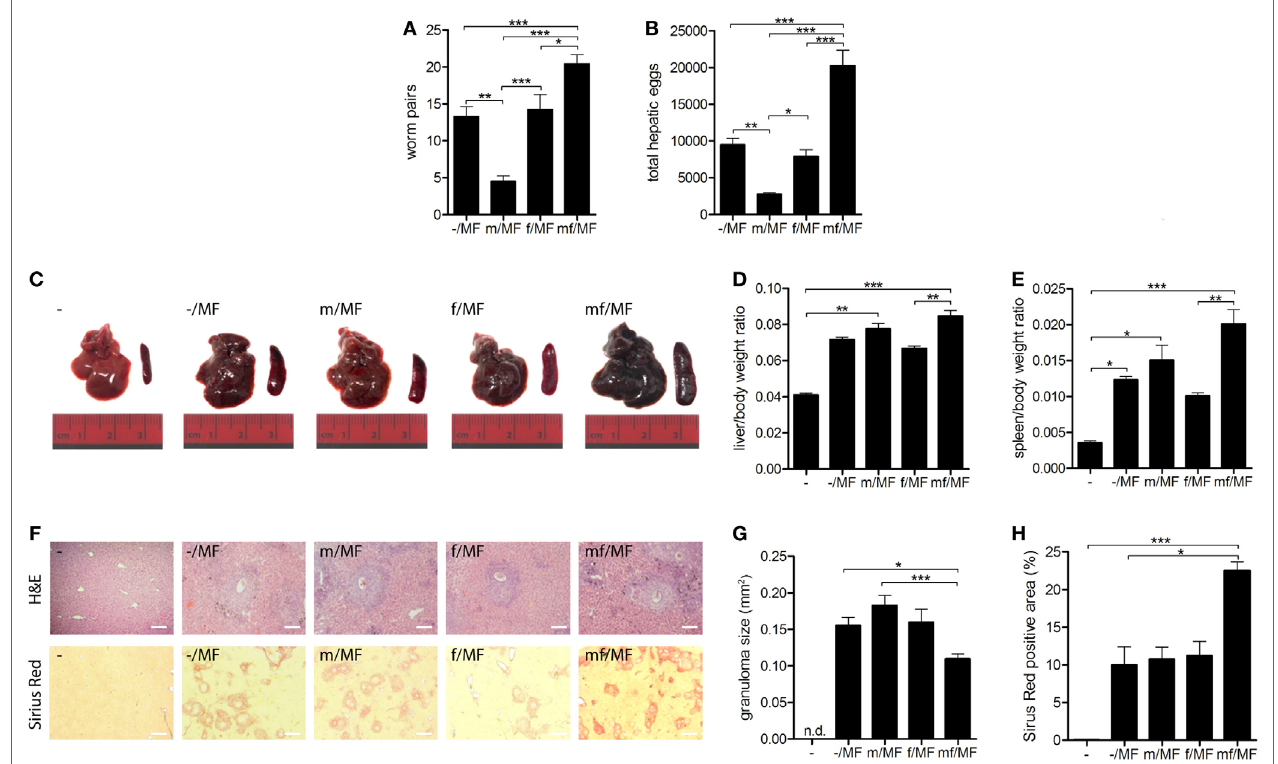
FigUre 5 | Primary infection with male schistosomes reduces worm and egg burden but has no impact on liver fibrosis. Six weeks p.i. mice were reinfected with (a,B) 150 or (c–h) 50 Schistosoma mansoni cercariae of both sexes (MF) and analyzed 8 weeks later. (a) Worm and (B) hepatic egg burden were quantified. (c) Representative images of livers and spleens. Relative organ size of (D) livers and (e) spleens expressed as a ratio to body weight. (F) Representative images of liver sections stained with hematoxylin/eosin and sirius red (magnification 100-fold). (g) Size of hepatic granulomas and (h) sirius red-stained area were quantified in Image J. Data are represented as mean + SEM; n = 5–8 mice each group; scale bar represents 200 µm. * p < 0.05, ** p < 0.01, *** p <